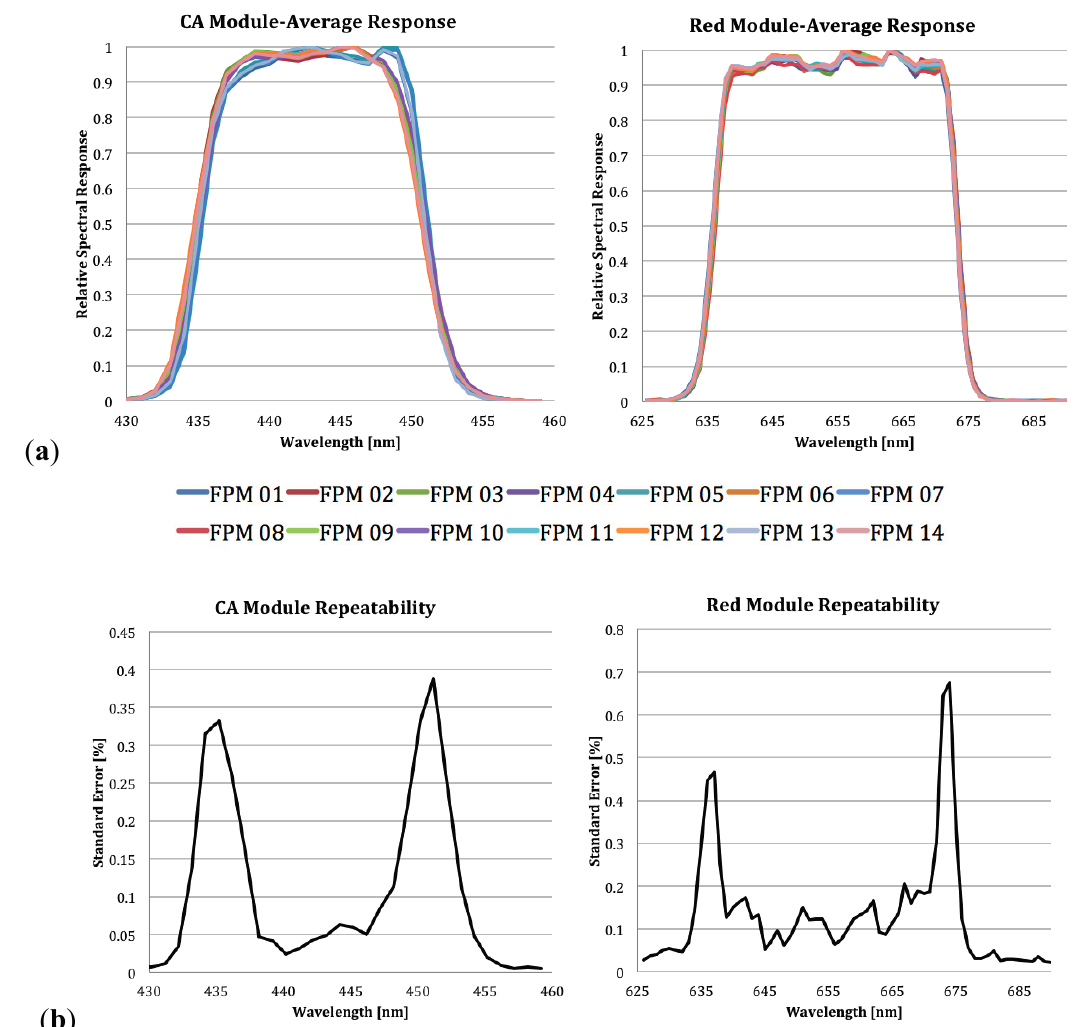
Figure 9. ( a ) OLI system FPM-average spectral response function for all modules on the focal plane for sample bands. ( b ) Uncertainty in response function based on the repeatability test, where the same test was repeated six times. The uncertainty is the standard error over all six tests and all 60 illuminated detectors.